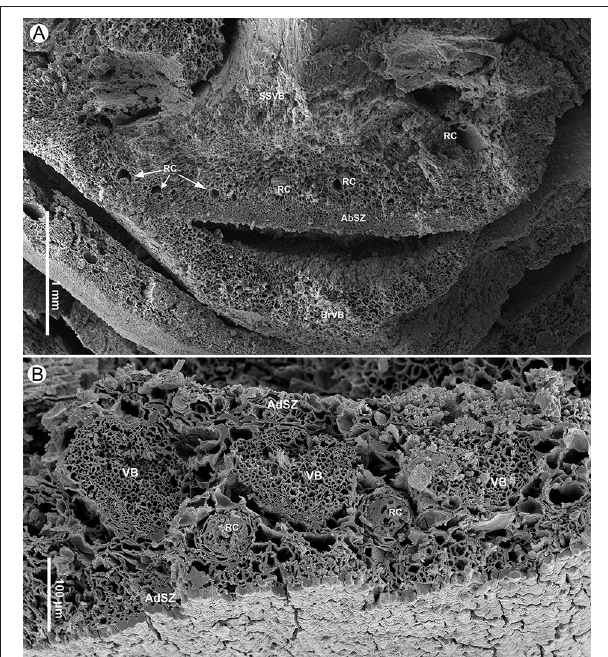
FIGURE 5 | Bract and seed scale anatomy of Pinus prehwangshanensis sp. nov., specimen MMRH171, SEM. (A) Transverse section of a bract-scale complex near its base showing the anatomy of a seed scale (SSVB – seed scale vascular bundles; RC – resin canals; AbSZ – abaxial sclerified zone) and a bract (BrVB – bract vascular bundles) separated from a seed scale by a medial pouch. (B) Transverse section of a seed scale in its lower third showing a sclerified cortex (AbSZ – abaxial sclerified zone; AdSZ – adaxial sclerified zone), slightly ellipsoidal to rounded vascular bundles (VB) without pronounced xylem rays and abaxial resin canals (RC).